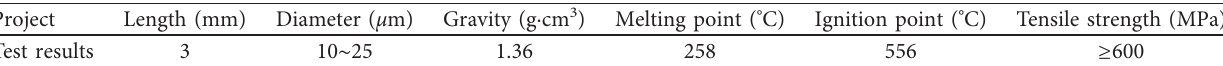
Table 4: Basic properties of PF.